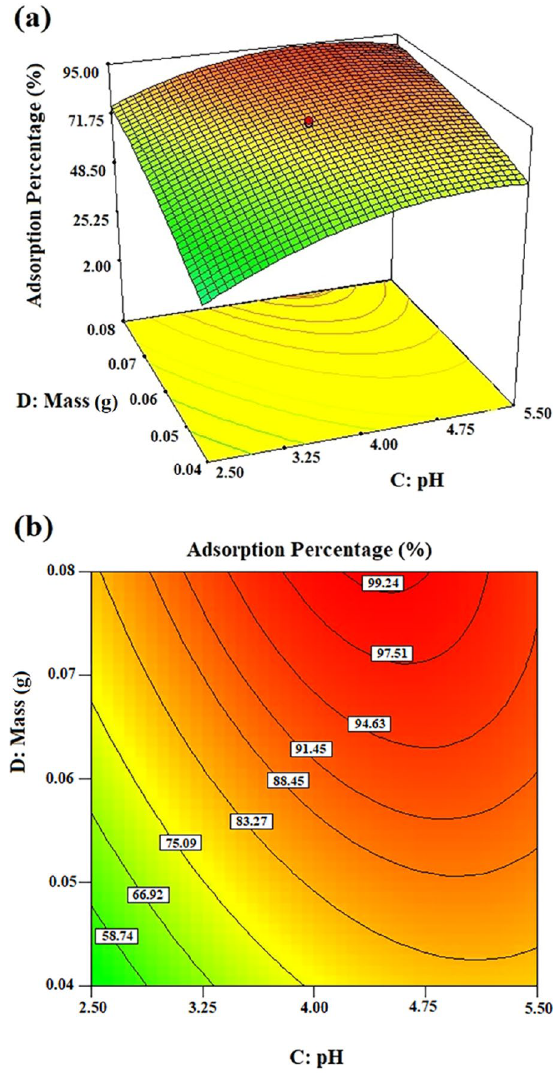
Figure 12. ( a ) 3D plot and ( b ) contour plot showing effect of adsorbent mass and pH on percentage adsorption of cobalt(II) ions (time = 130 min; Co(II) ions in aqueous solution = 60